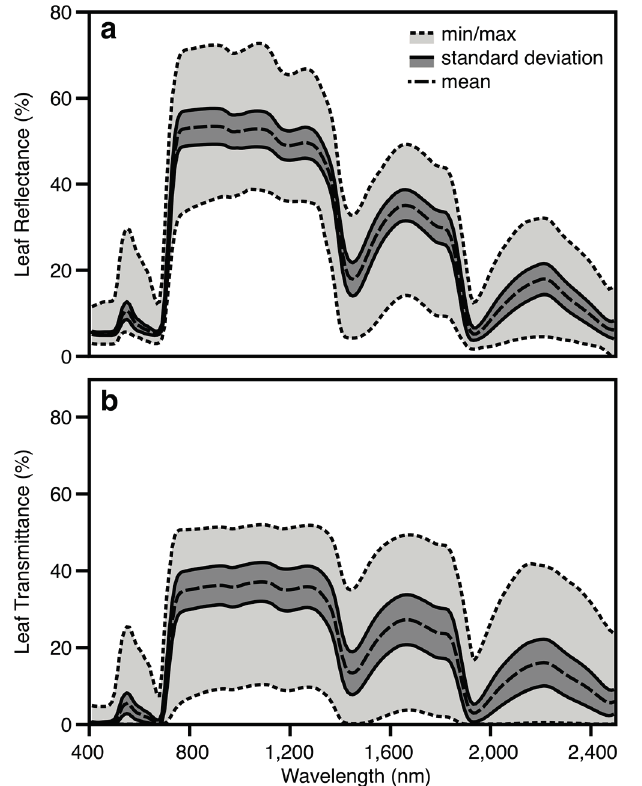
Figure 4. Leaf-level ( a ) reflectance and ( b ) transmittance spectra of fresh (live) samples collected from 6136 forest canopy growth-forms in sub-tropical and tropical forests worldwide. The locations of the sample collections are shown in Figure 2, and the general site information is provided in Table 1. The thick dashed line indicates mean values; dark grey areas indicate one standard deviation; light grey areas indicate the total range of